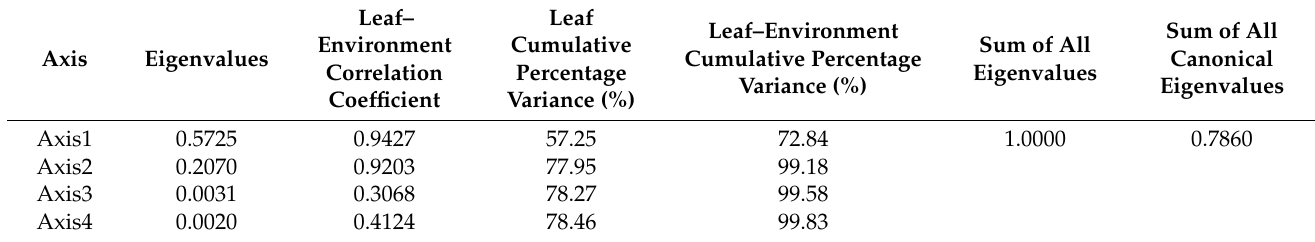
Table 4. RDA ranking of leaf functional traits and soil factors of H. tibetana